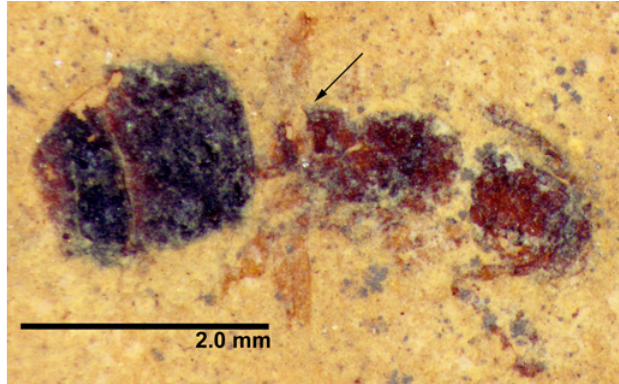
Fig 2. Holotype worker, Dolichoderus dlusskyi (USNM# 609584). Arrow indicates propodeal